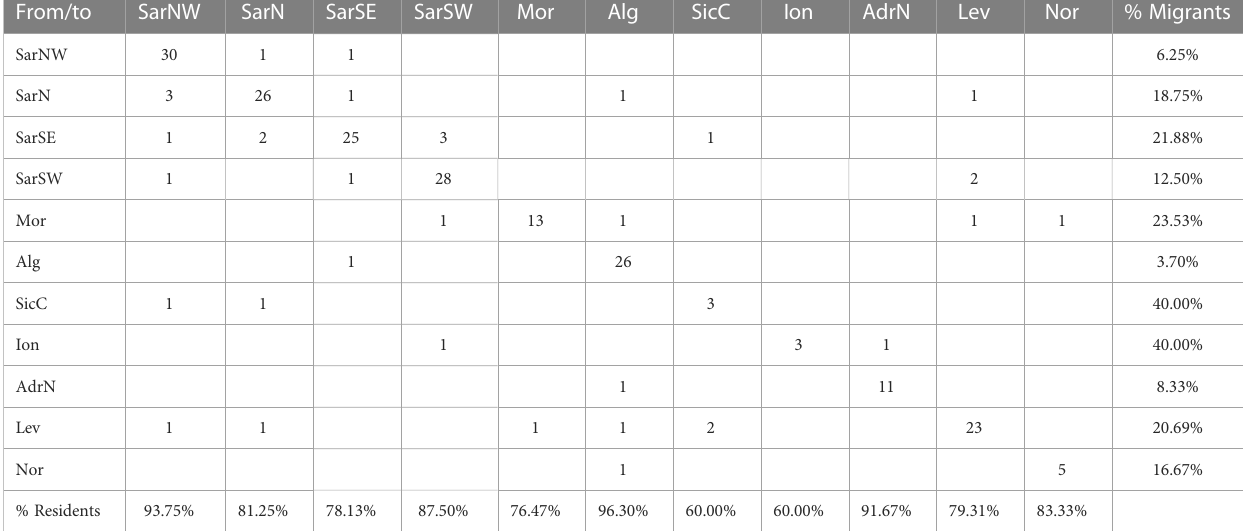
TABLE 5 First generation migrants as detected by Geneclass. From/to